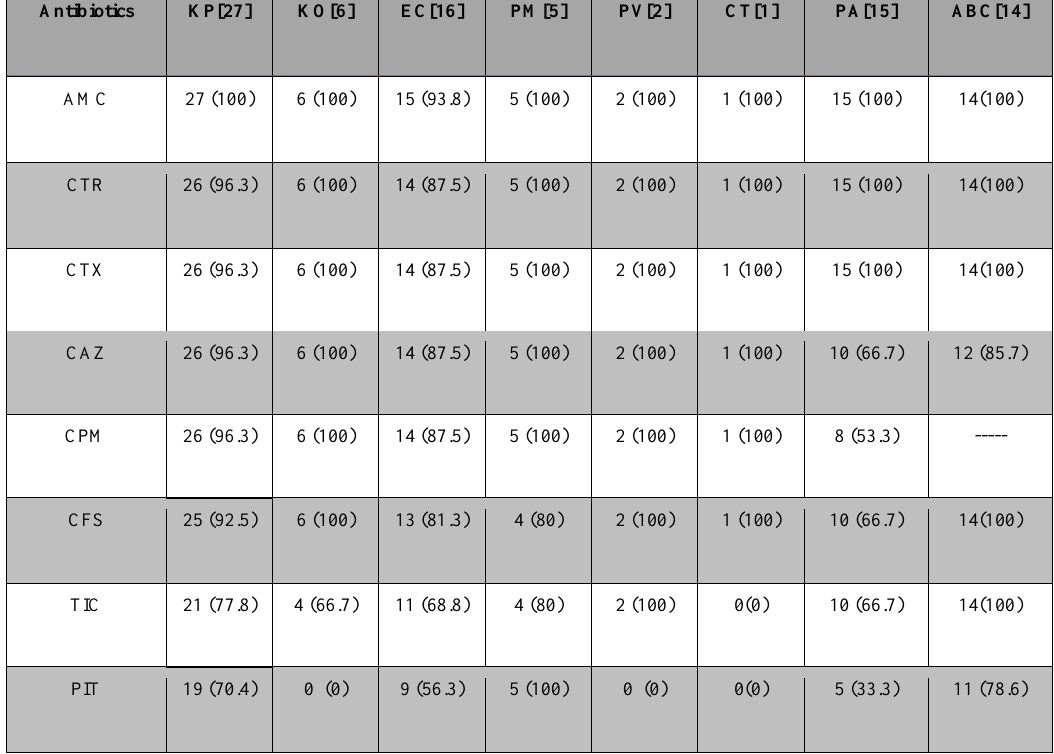
Table 2. Antibiotic resistance pattern of gram-negative isolates with percentage paradigm in parentheses (n= 86).